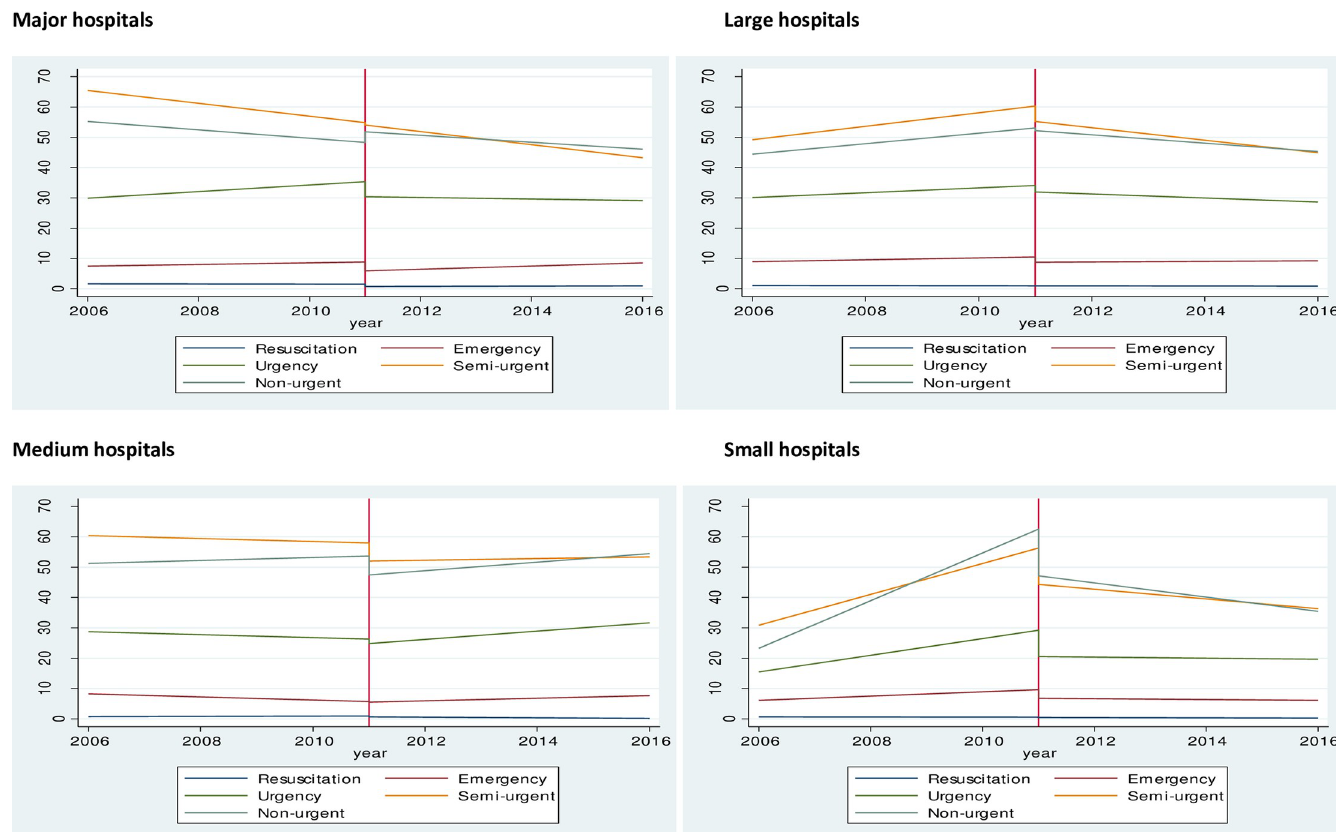
Fig 2. Mean time to treatment (minutes) by triage categories, year of presentation and hospital peer groups.